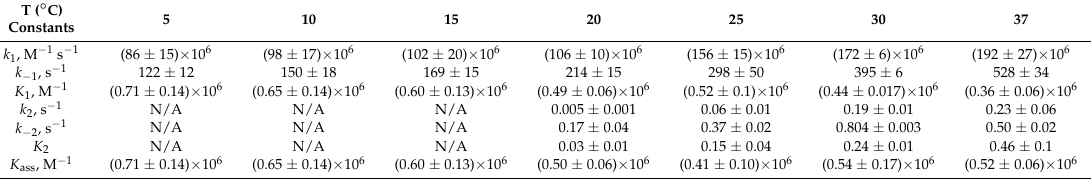
Table 3. Rate and equilibrium constants corresponding to the interaction of Endo III with F-ligand. T( ◦ C)